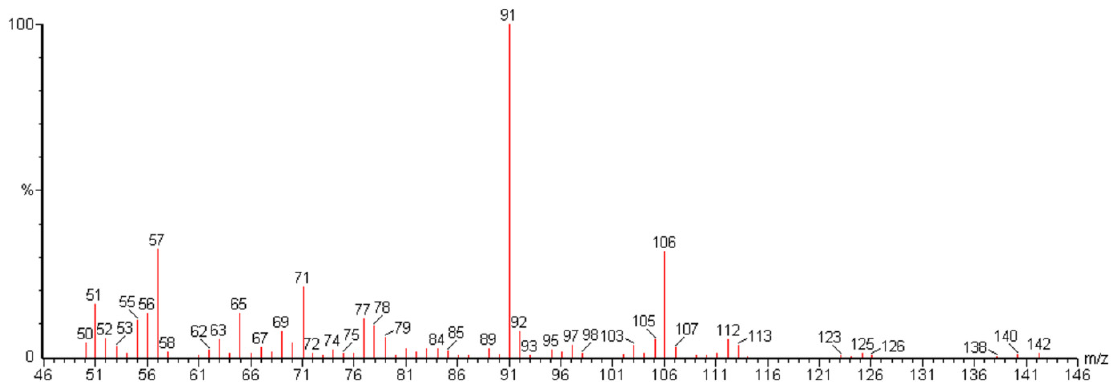
Figure 5. MS spectrum for the peak with a retention time of 8.20 min.